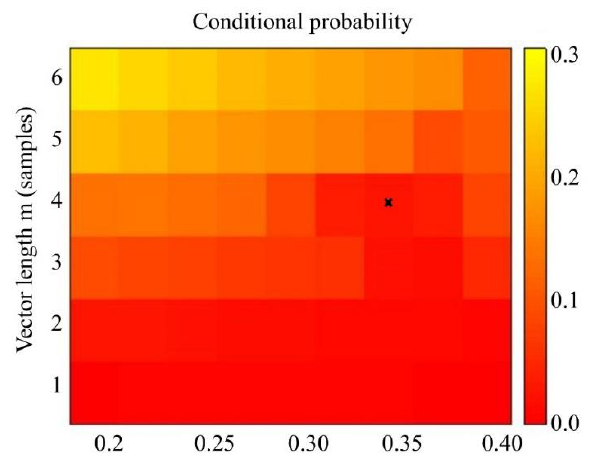
Figure 5. Maximum relative error of the sample entropy or conditional probability, as a function of m and r . Optimal parameters m = 4, r = 0.35.